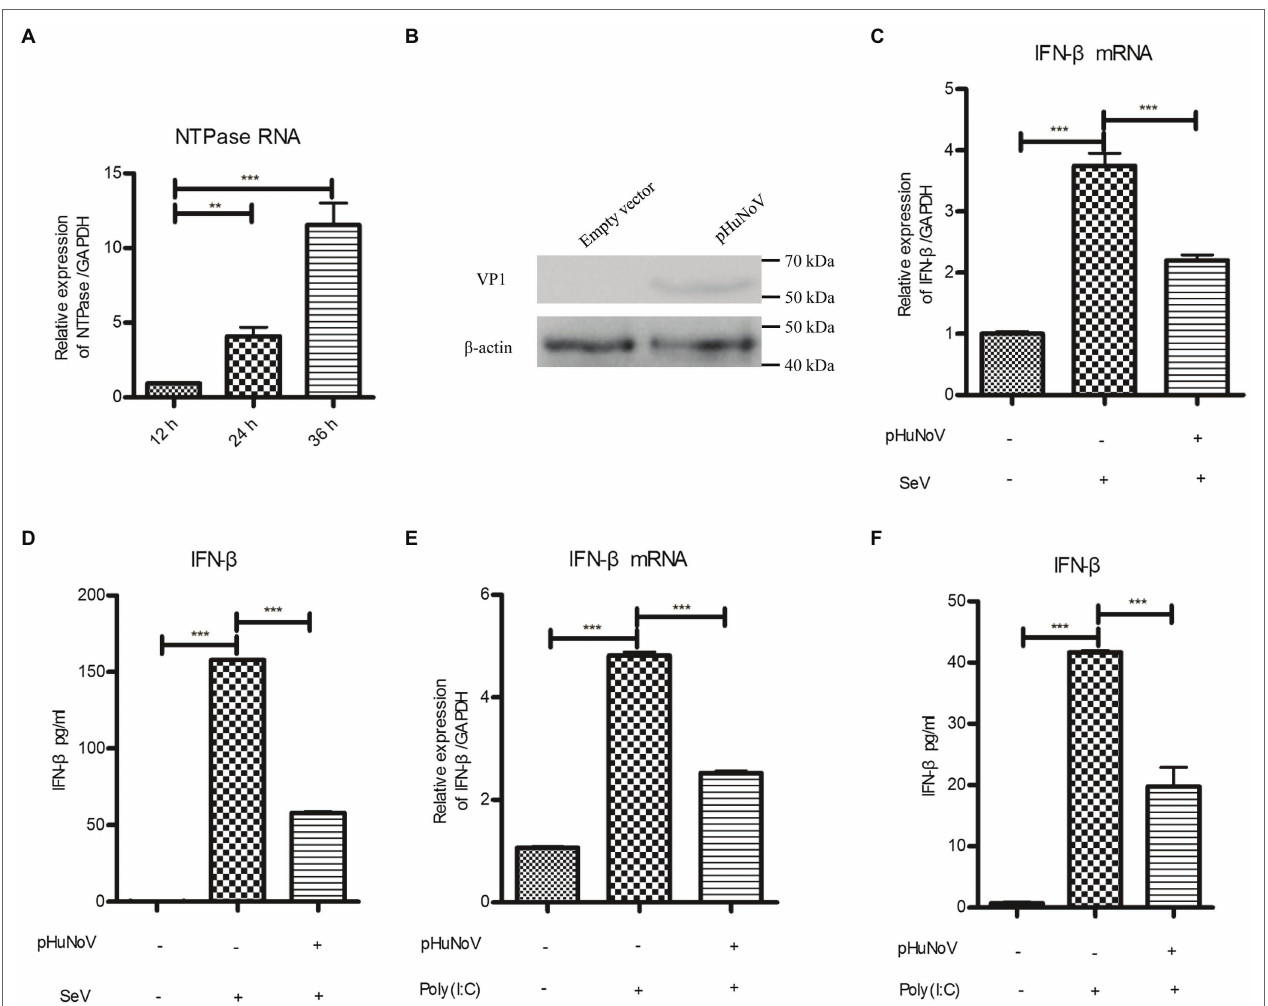
FIGURE 1 | A cDNA clone of human norovirus (HuNoV) inhibits the production of interferons (IFN- β ) induced by Sendai virus (SeV) and polyinosinic-polycytidylic acid [Poly(I:C)]. (A) Identification of HuNoV RNA expression in cells transfected with a HuNoV cDNA clone. 3 μ g pHuNoV was transfected into Caco-2 cells preseeded in 6-well plates. At the indicated time posttransfection, total RNA was extracted from transfected cells to measure NTPase RNA by real-time PCR. (B) Identification of HuNoV protein expression in cells transfected with a HuNoV cDNA clone. 3 μ g pHuNoV or empty vector was transfected into Caco-2